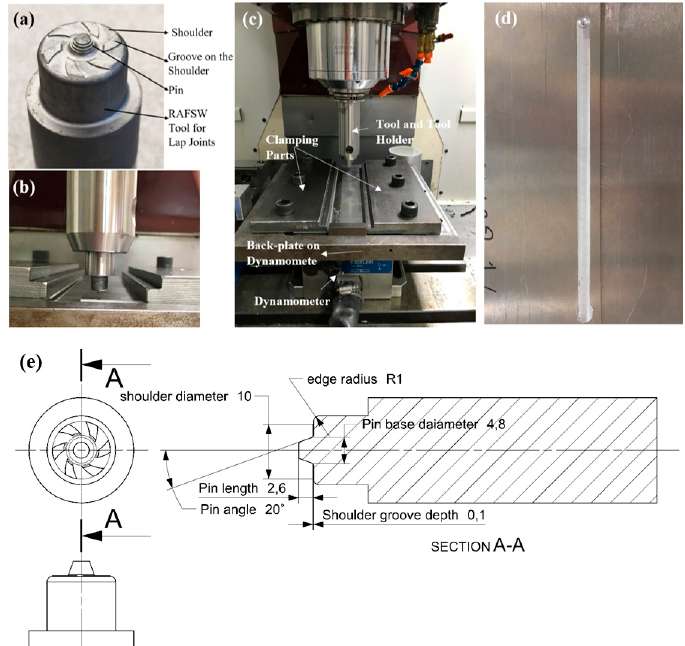
Figure 1. ( a ) The tool shape to make lap joints by the friction stir welding technique at right angle (RAFSW) technique; ( b ) The close view of the tool and tool holder; ( c ) The RAFSW set-up including the tool, tool holder, clamped sheets on the back-plate and the back-plate installed on the dynamometer; ( d ) The welded sample; ( e ) The schematic of the tool and the design parameters (the pin lead, not illustrated, is the distance between the threads on the pin).